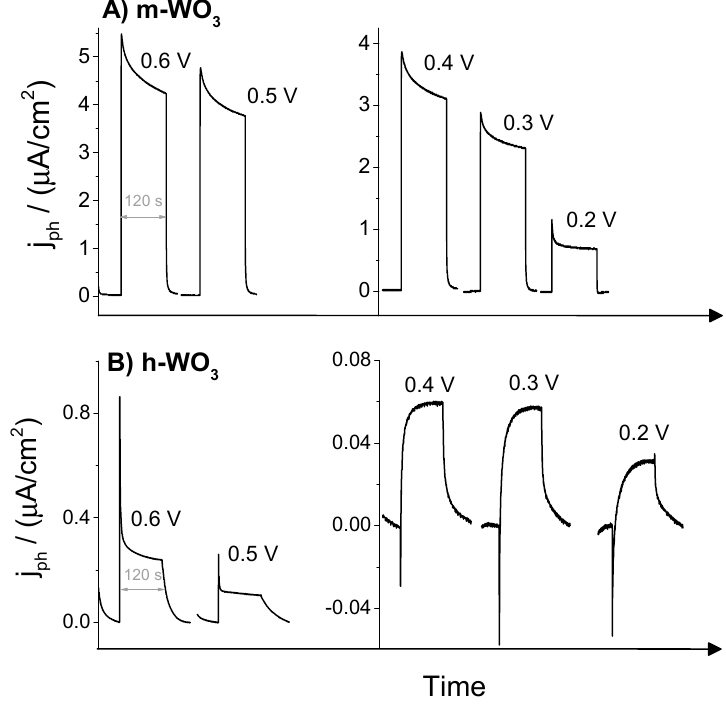
Figure 4. Transient photocurrent responses for ( A ) m-WO 3 and ( B ) h-WO 3 electrodes at various bias potentials between 0.2–0.6 V vs. Ag/AgCl under illumination (2 min) at 371 nm (photon flux of 3.4 × 10 14 cm − 2 s − 1 ).